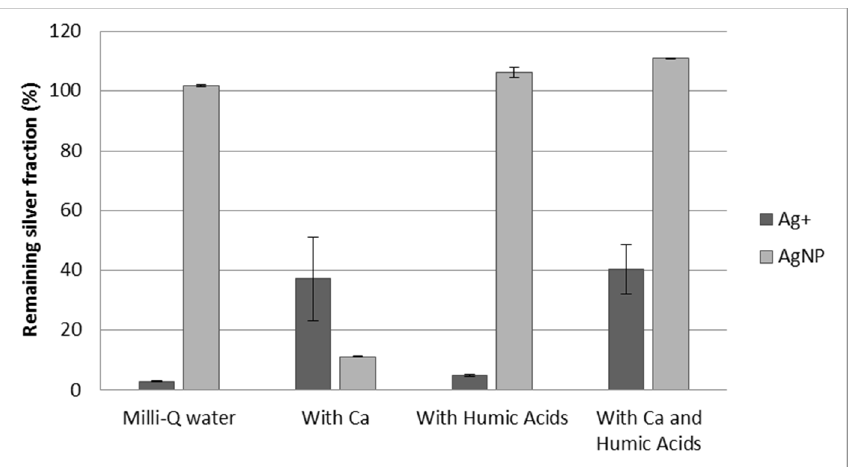
Figure 3. Remaining silver fraction (Ag + or AgNPs) after 60 min of contact with 10 mg of resin in Na + form. Error bars represent standard deviation n = 2. Initial silver concentration is 100 μg·kg − 1 for both Ag + and AgNPs.